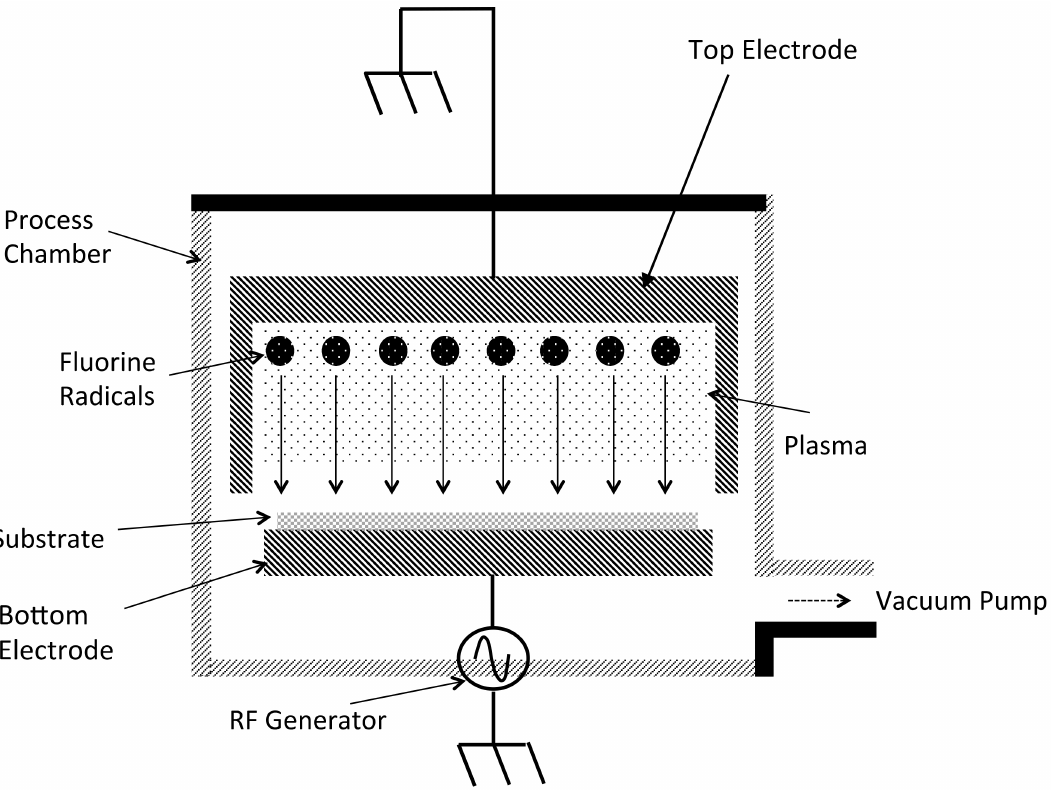
Figure 4. Illustration of a reactive ion etch (RIE) etching system [13]. Inlet process gas lines are not